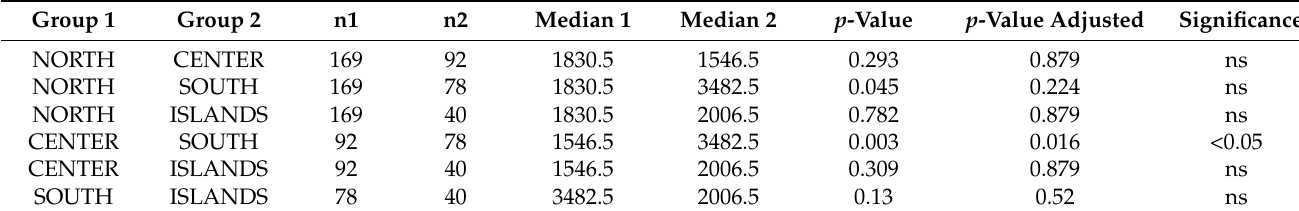
Table 6 . Pairwise Wilcoxon rank-sum tests in the number of followers for the area. Table 6. Pairwise Wilcoxon rank-sum tests in the number of followers for the area.